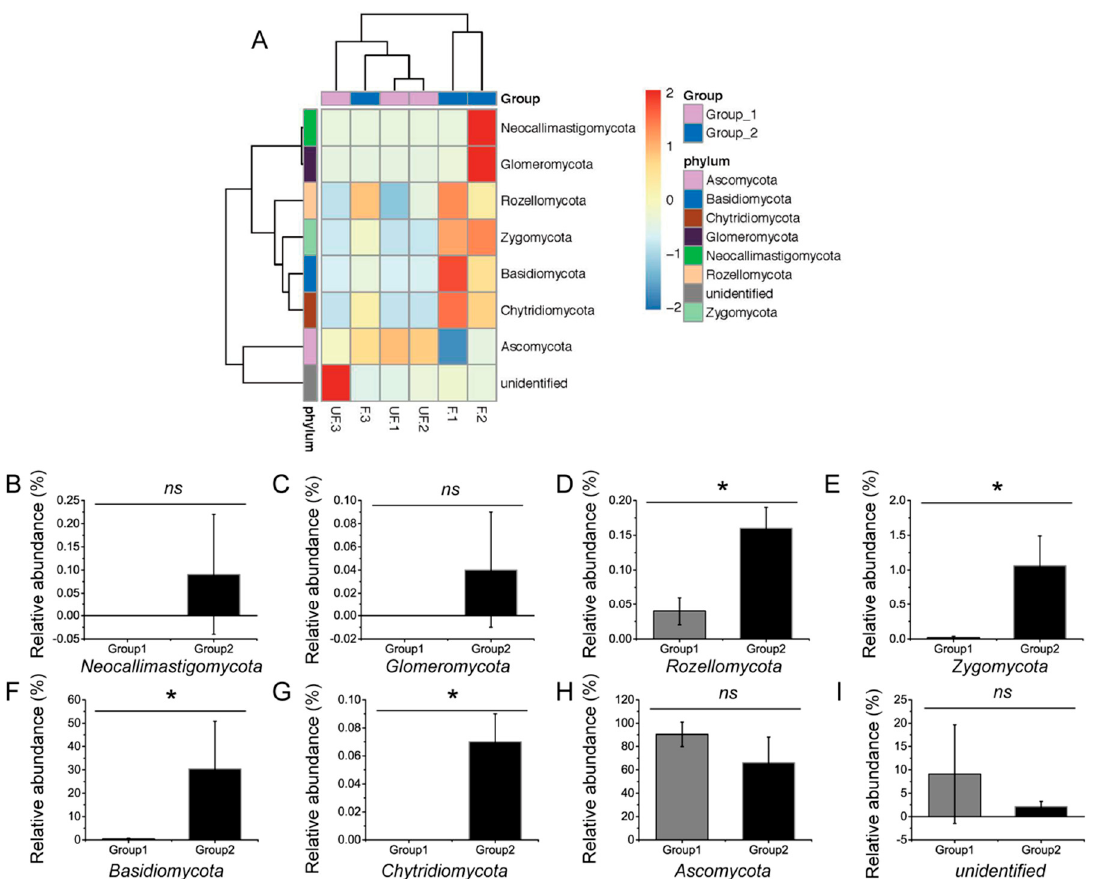
Figure 4. Comparative analysis of the microbial abundance in the dominant phyla. ( A ) Heat map analysis of the dominant phyla in the non-fertilized and fertilized eggs of N. lugens . ( B – I ) Comparative analysis of the abundance of Basidiomycota, Ascomycota, Chytridiomycota, Glomeromycota, Neocallimastigomycota, Rozellomycota, Zygomycota, and unidentified phylum, respectively. Groups 1 and 2 represent the non-fertilized and fertilized eggs of N. lugens , respectively. Ns: no significant di ff erence between the non-fertilized and fertilized eggs at p < 0.05 levels; * significant di ff erence between the non-fertilized and fertilized eggs at p < 0.05 levels.